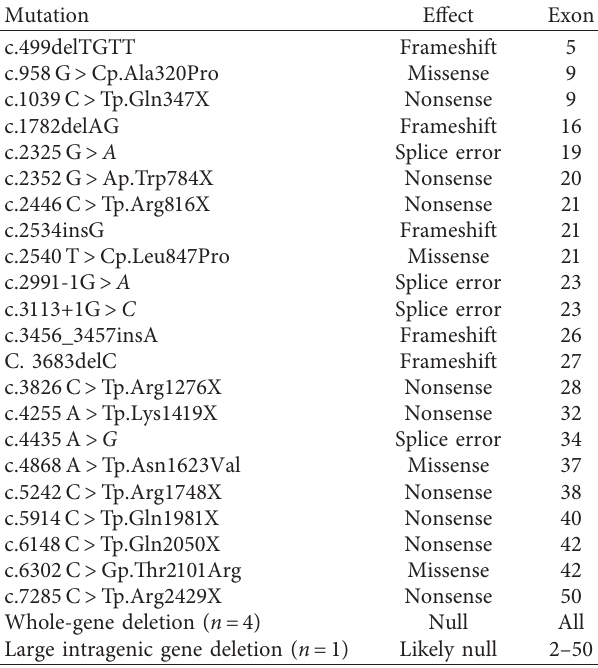
Table 2: MPNST-related NF1 germline mutations.